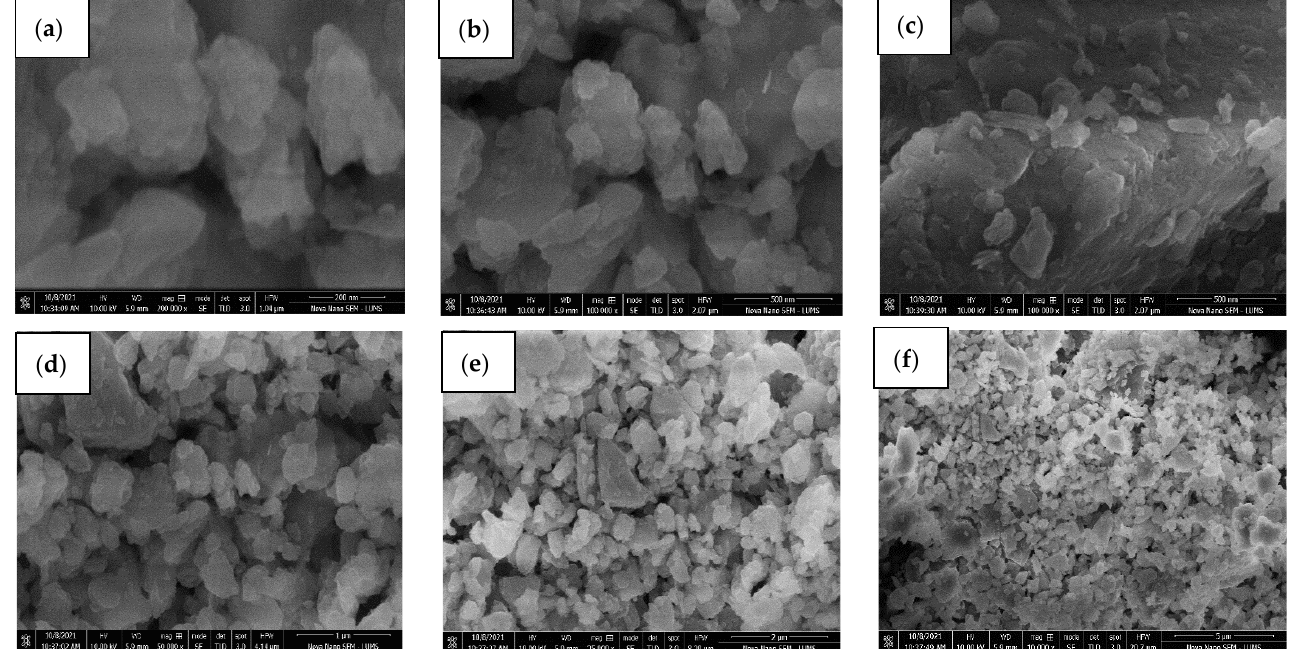
Figure 9. SEM images of potassium ferricyanide and sodium metasilicate treated golden marble powder at various resolutions, ( a ) 200 nm, ( b ) 500 nm, ( c ) 500 nm, ( d ) 2 μ m, ( e ) 4 μ m, and ( f ) 5 μ m.